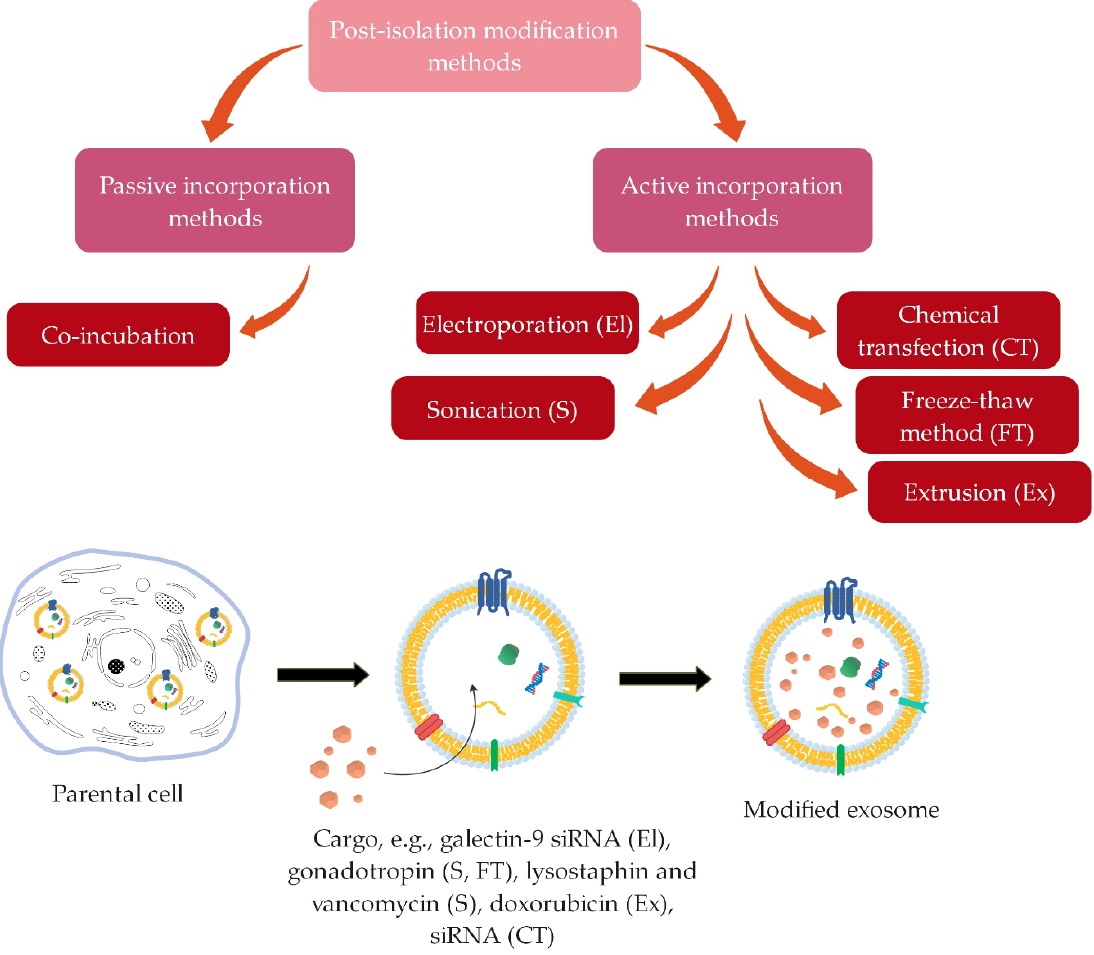
Figure 5. Principle of post-isolation exosomes modification methods, where the desired therapeutic agents can be encapsulated in purified exosomes, directly after their isolation from cells, either through passive (co-incubation) or active incorporation methods (summarized from [14–16,79–84]).